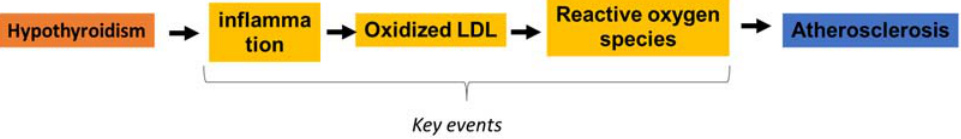
Figure 3. Postulated MoA for CS 2 : decreased TH levels and subsequent adverse atherosclerosis, adapted from Duntas et al. (2018).